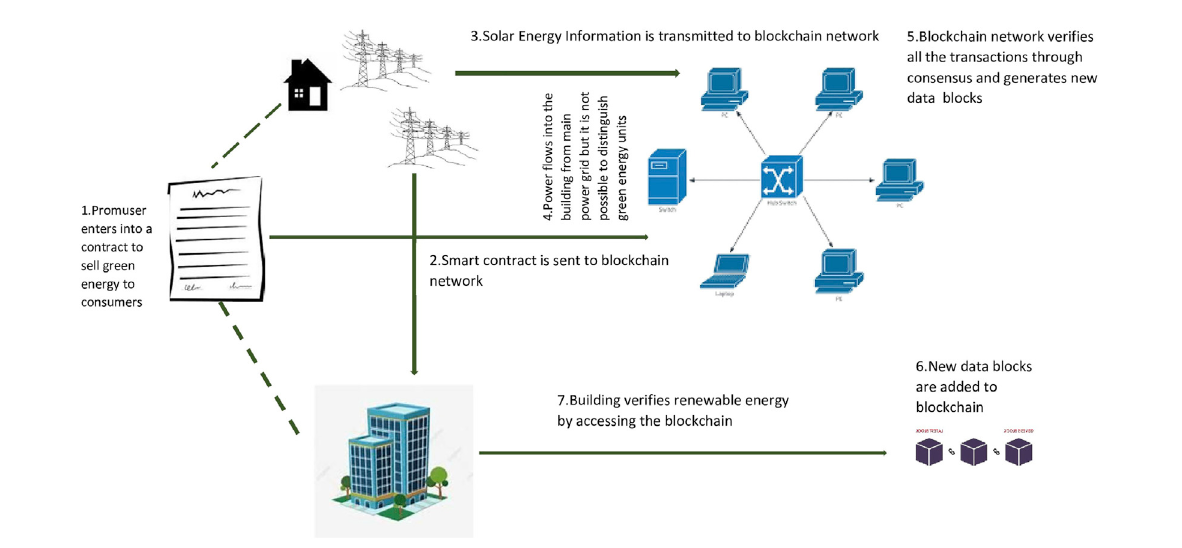
FIGURE 3 Work fl ow of smart energy meter with blockchain and